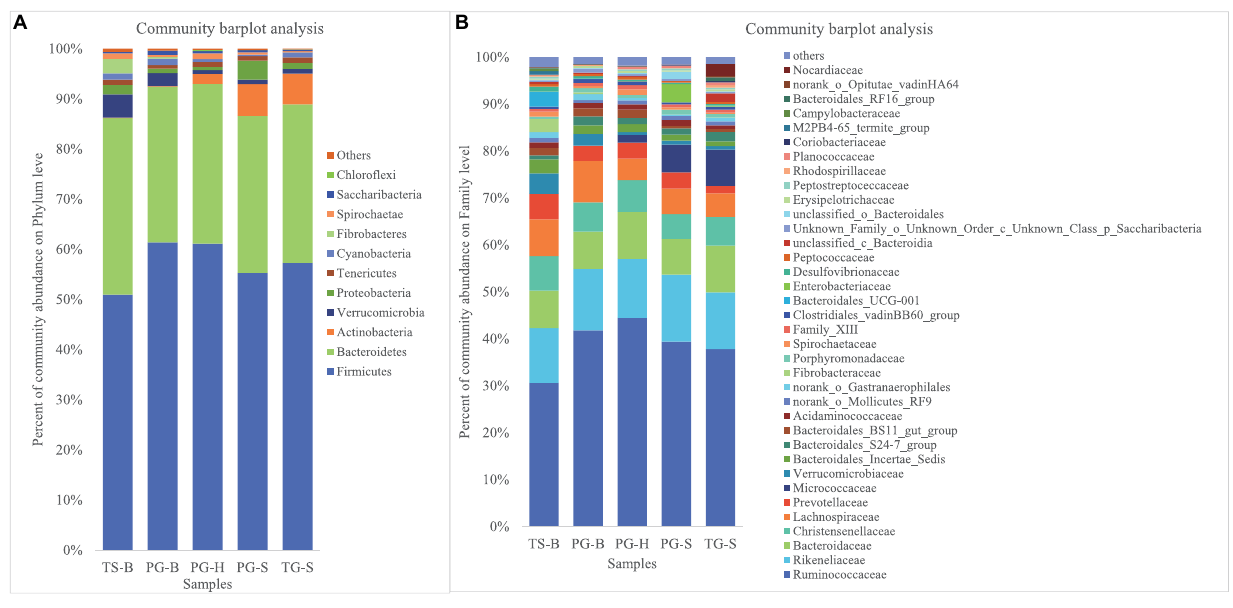
FIGURE 2 | (A) Fecal bacterial community at the phylum levels. Phyla with less than 1% abundance were merged into others. (B) Fecal bacterial community at the family levels. Family with less than 1% abundance were merged into others. TS-B, Tibetan sheep on Bird Island; PG-B, Przewalski’s gazelle on Bird Island;